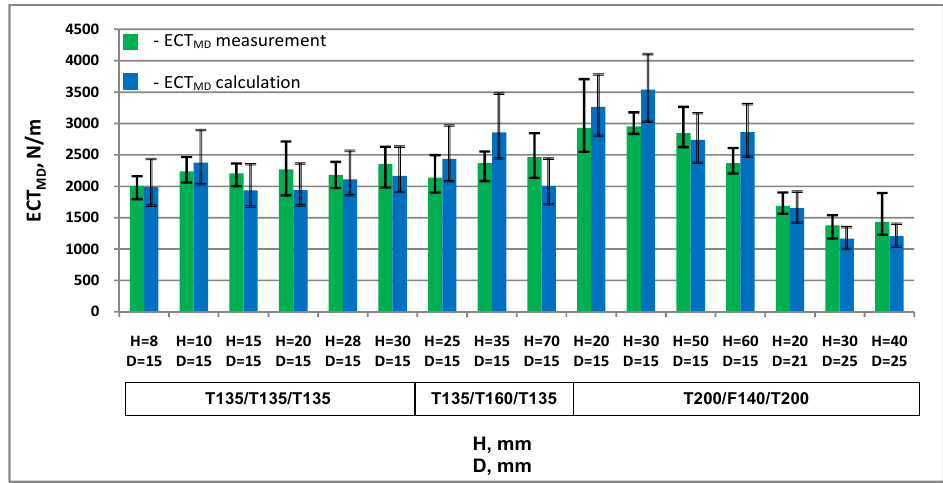
Figure 7. Resistance of honeycomb paperboard to edge crushing in the machine direction.